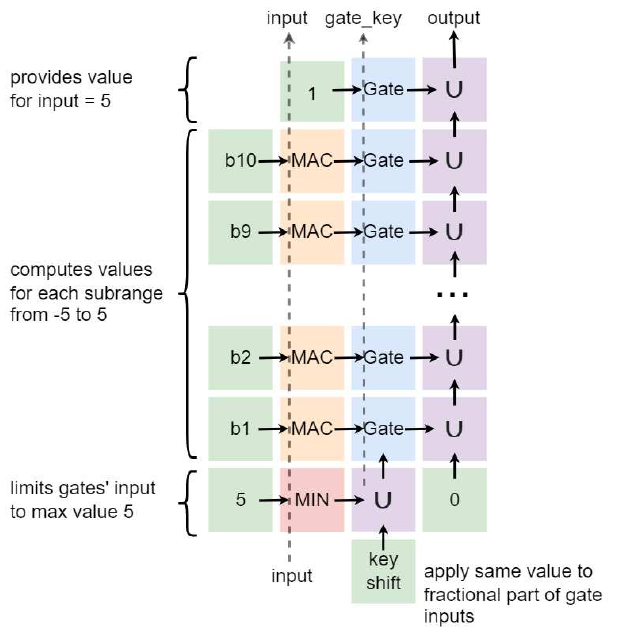
Figure 13. Distributed implementation of sigmoid